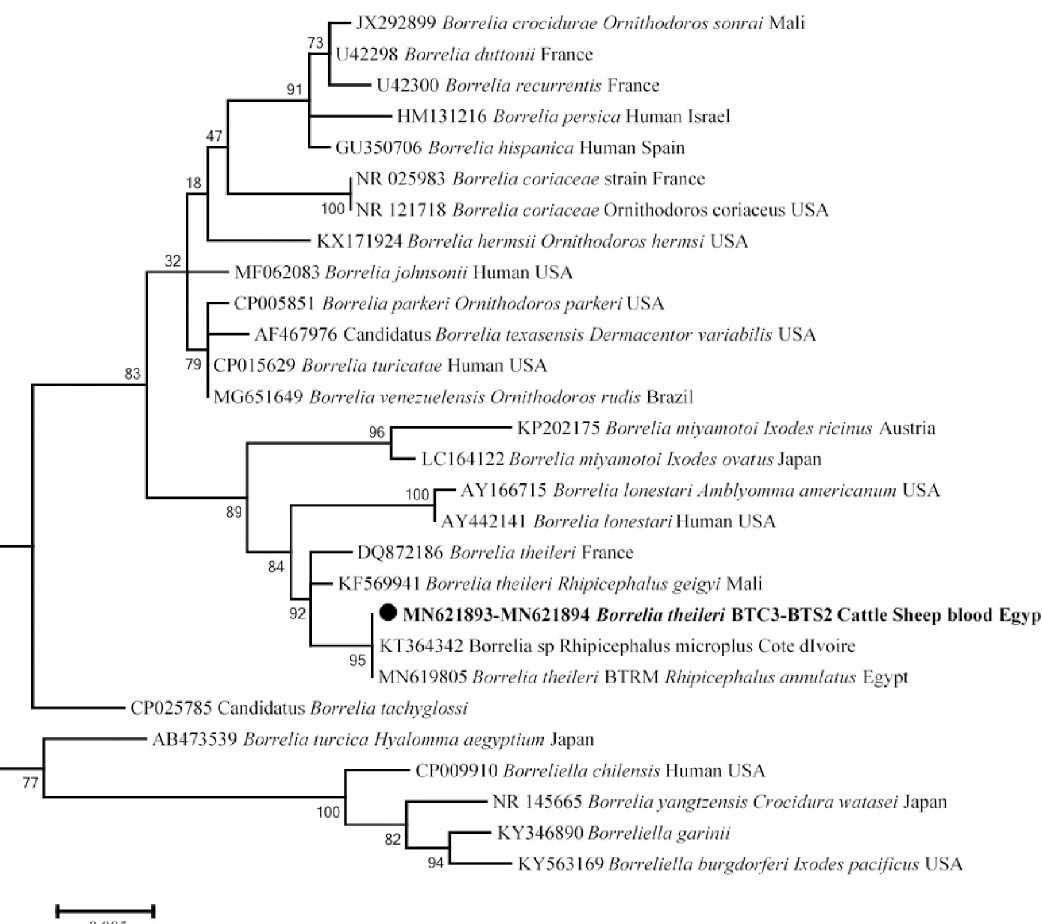
Fig 6. 16S rRNA based phylogenetic analysis of genotypes identified in this study. Phylogenetic tree highlighting the position of Borrelia sp. in the present study ( Bold ) related to other Borrelia sp. available in GenBank. The sequence of 16S rRNA were aligned using CLUSTAL W and phylogenetic inferences were constructed in MEGA X using Maximum Likelihood based on Tamura-Nei Model for nucleotide sequences with 500 bootstrap replicates. There was a total of 1142 positions in the final dataset. The scale bar represents a 5% nucleotide sequence divergence.